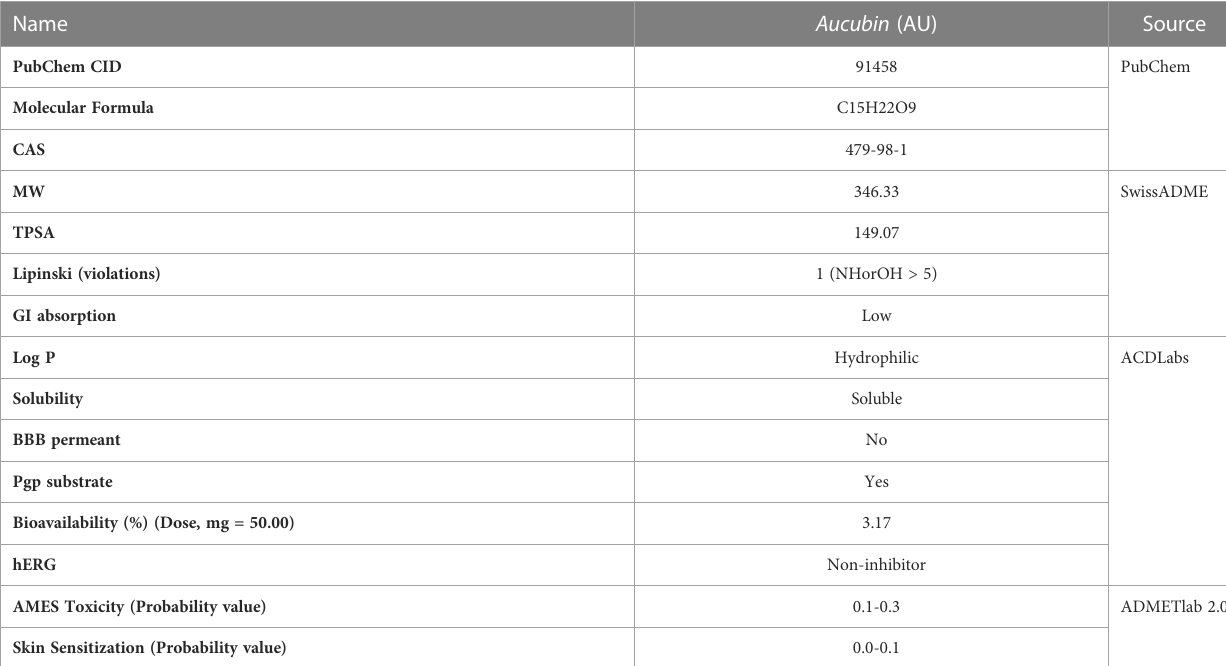
TABLE 2 ADMET properties of AU by ACD/Labs, SwissADME and ADMETlab